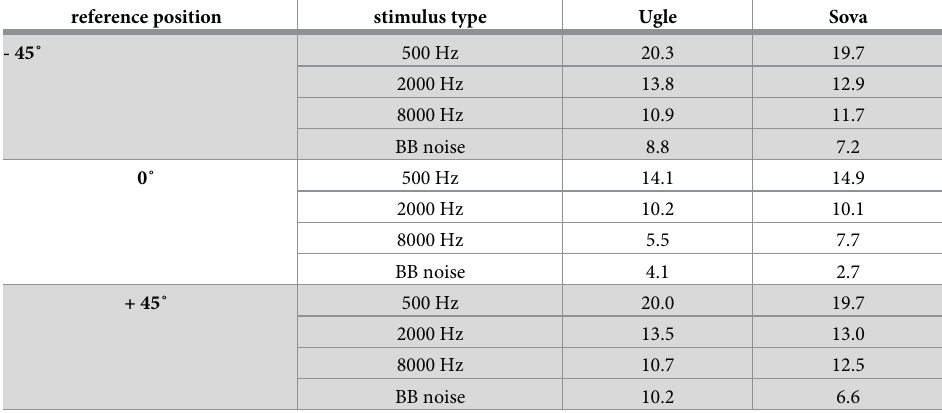
Table 2. MAA values in degree of two barn owls (Ugle and Sova) as a function of reference position and stimulus type. Data were obtained in the multiple reference paradigm. reference